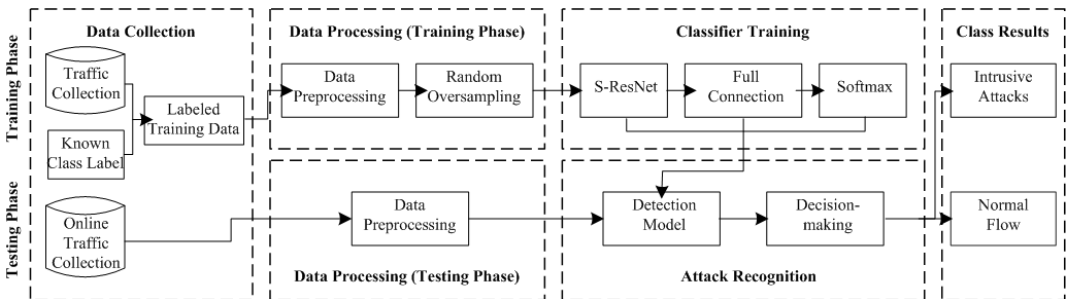
Figure 5. The application scenario of the above IDS.